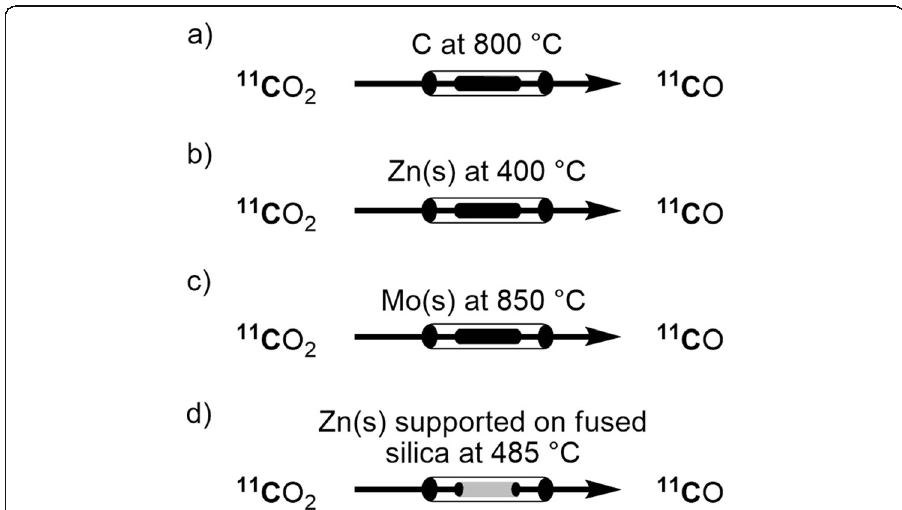
Fig. 2 ‘ Gas-phase ’ [ 11 C]carbon dioxide reduction on heated columns of: a activated charcoal; b Zn; c